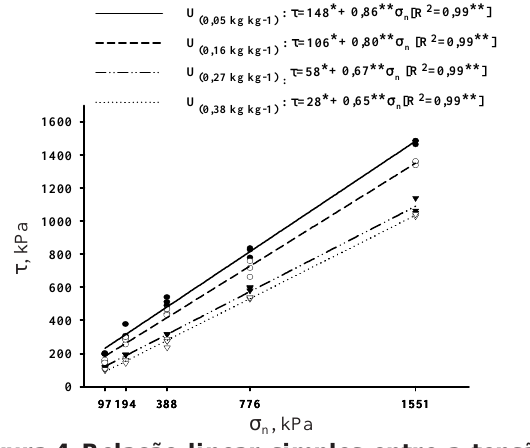
Figura 5. Relação linear simples entre a tensão ) e tensão cisalhante ( τττττ ) do Latossolo normal ( σσσσσ n Vermelho distrófico, sob preparo convencional (PC), submetido a diferentes teores de água.